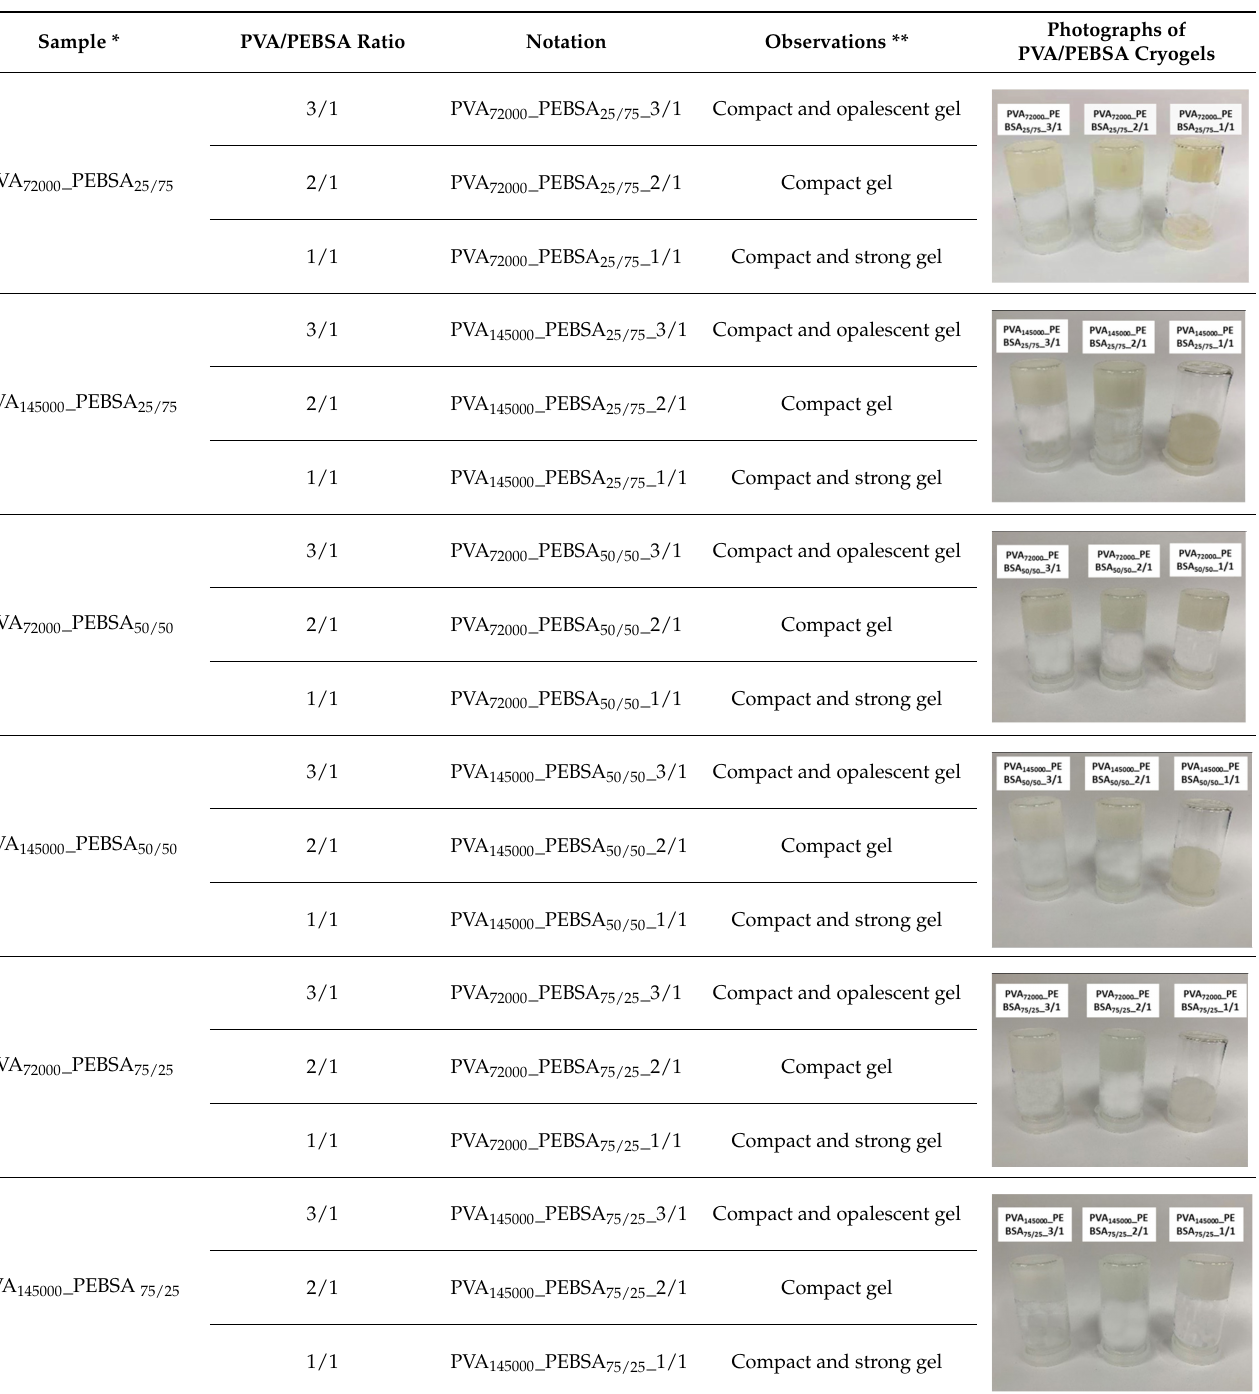
Table 1. Sample names and methods of